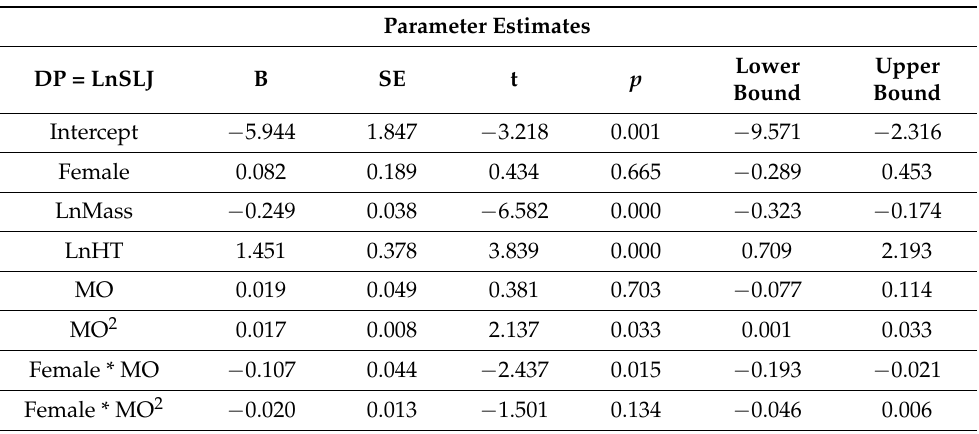
Parameter Estimates